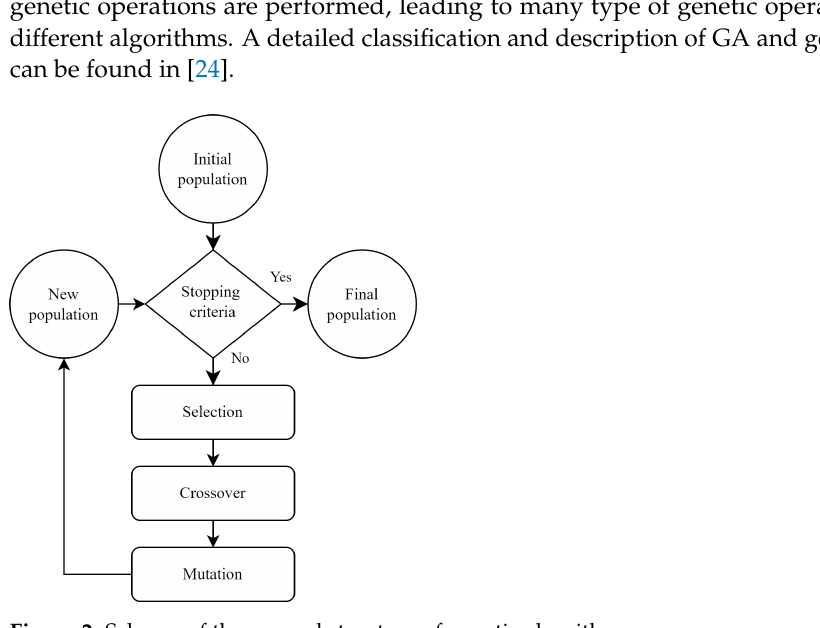
Figure 2. Scheme of the general structure of genetic